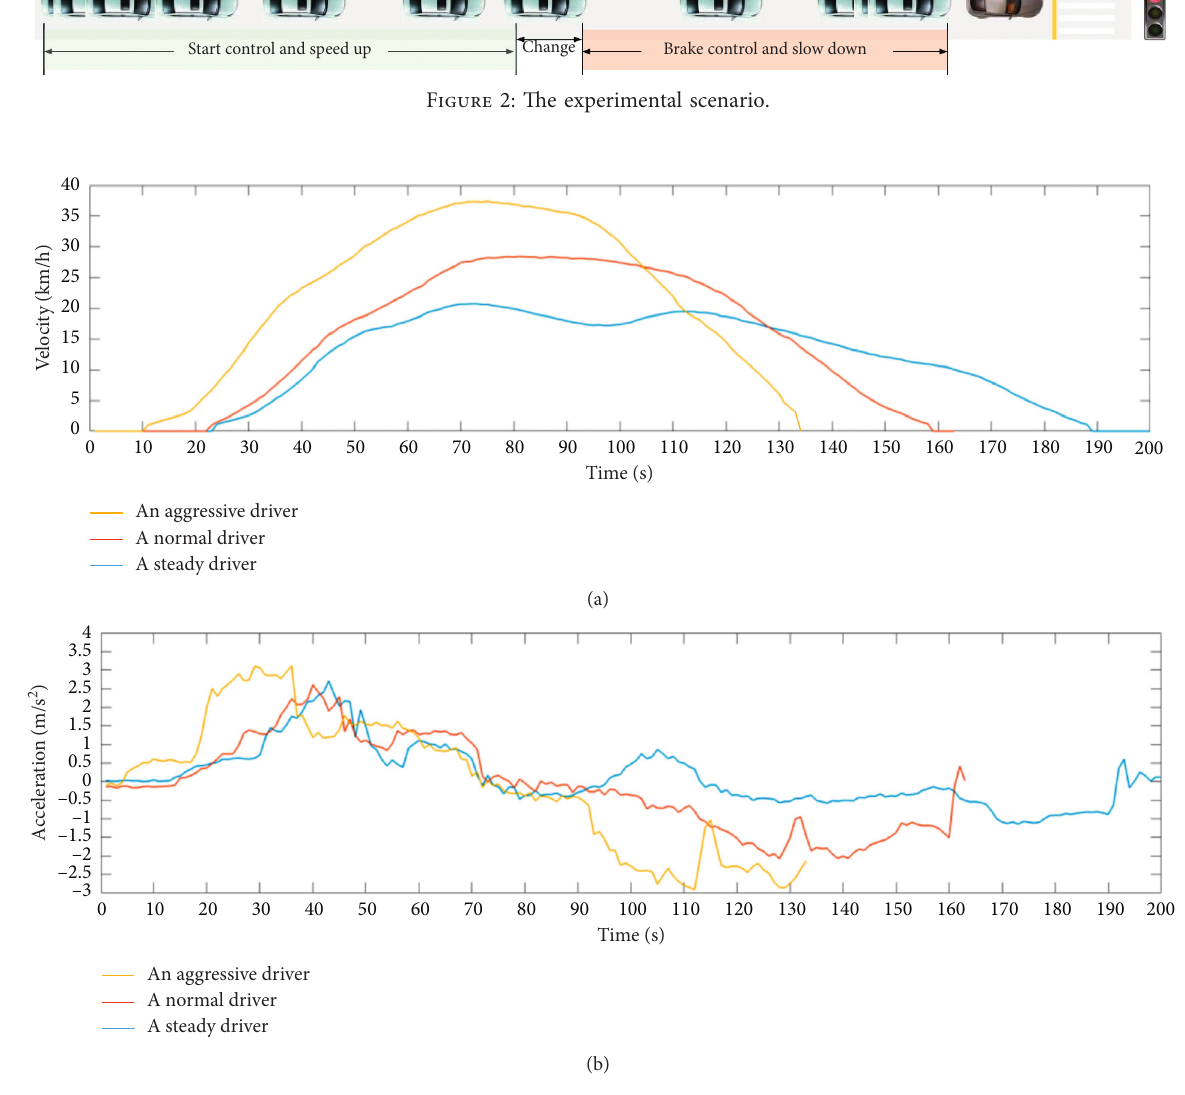
Figure 3: The experimental results for three drivers in the vehicle stop-and-go